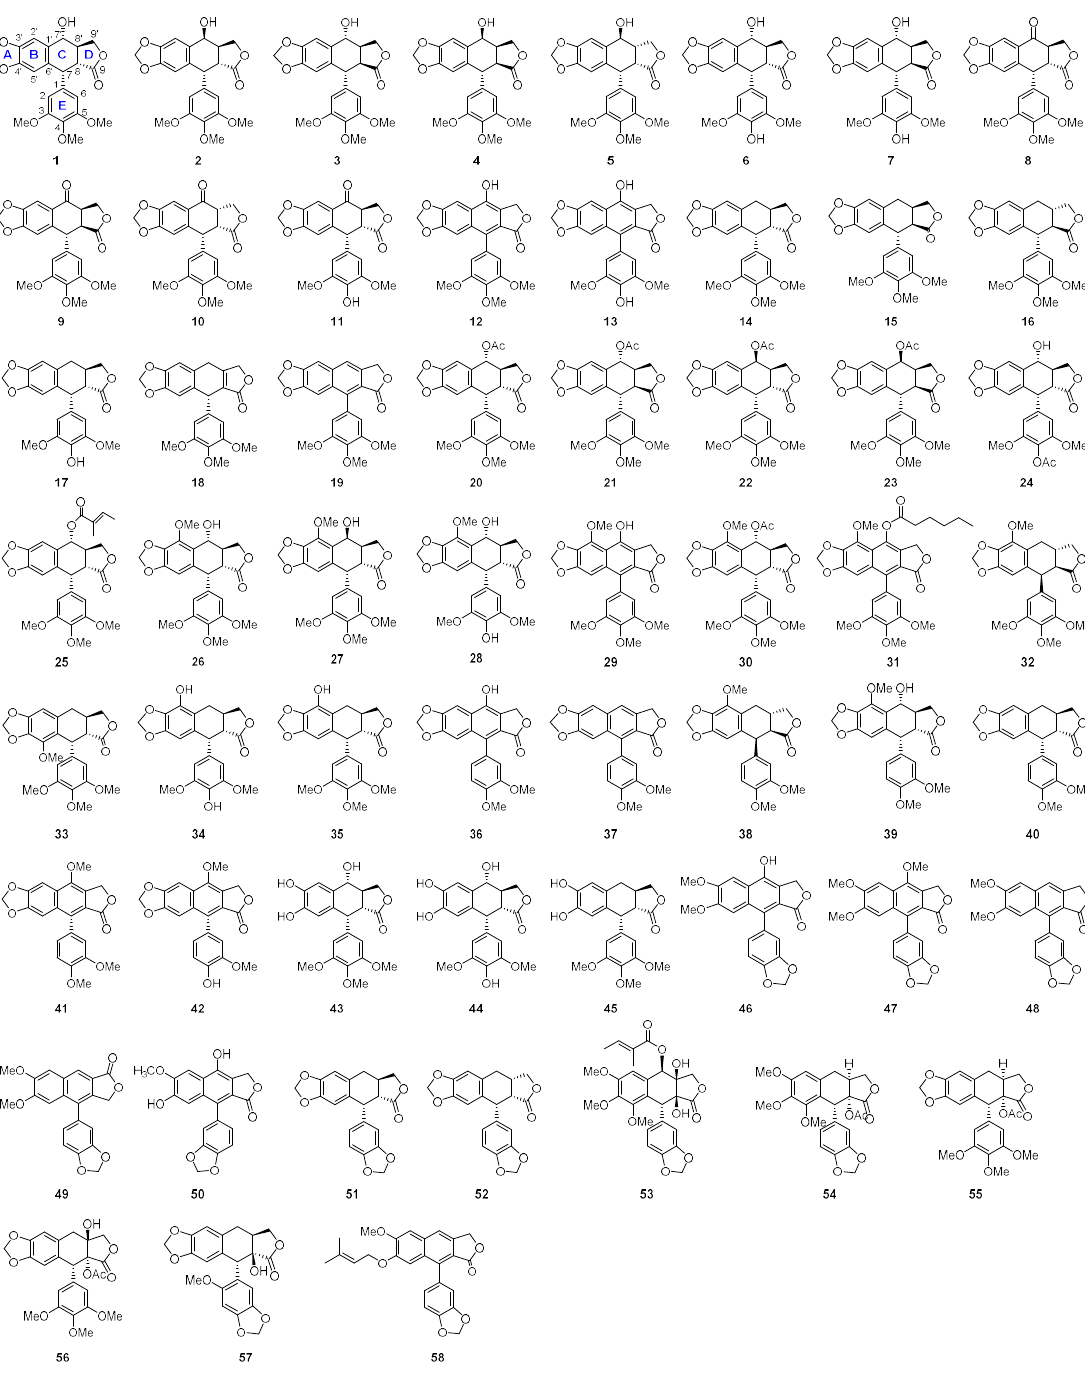
Figure 1. Chemical structures of natural podophyllotoxins aglycones.